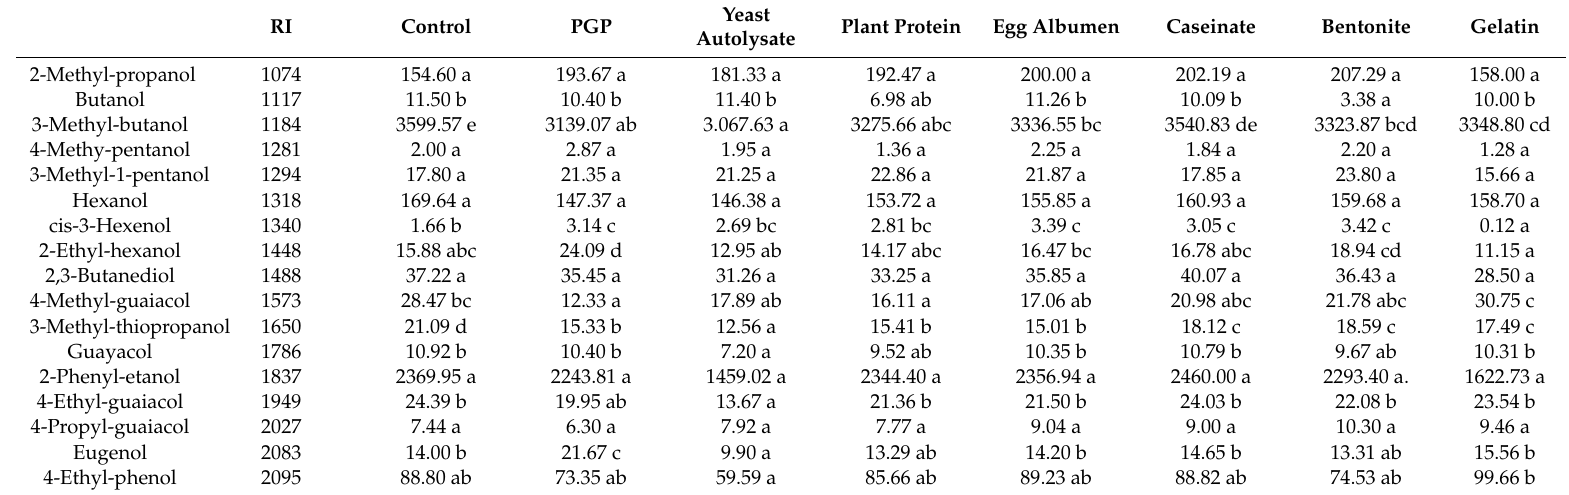
Table 1. E ff ect of the fining agents on fusel alcohol compounds ( µ g equivalents of 2-octanol /